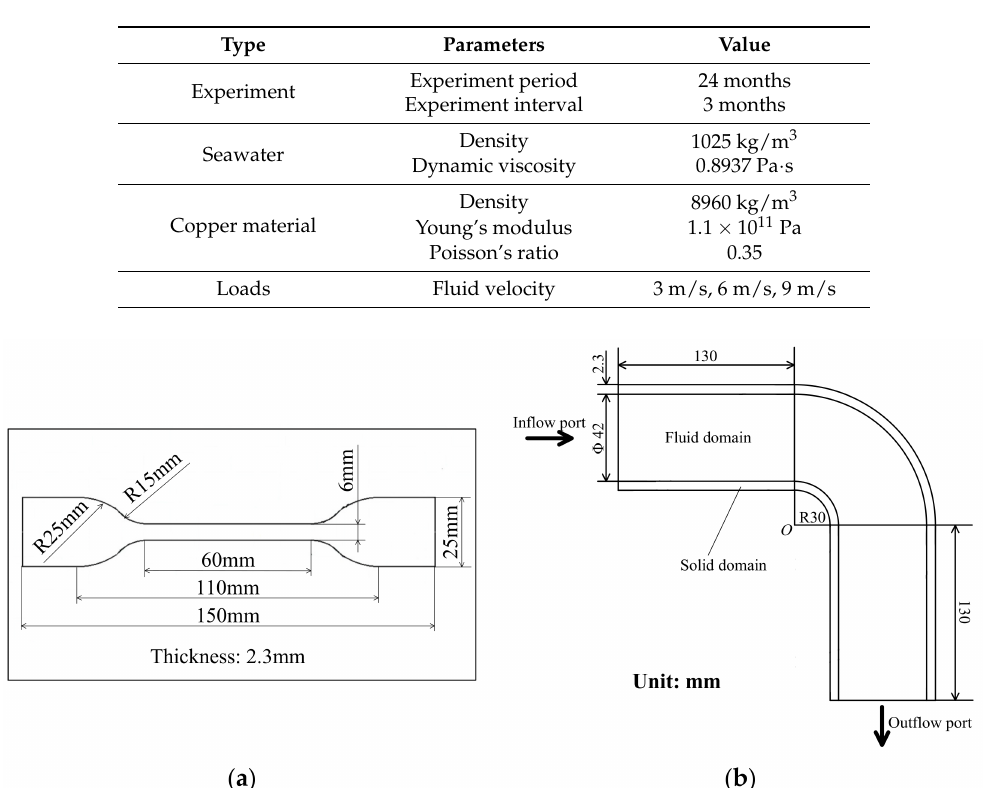
Table 1. Experiment description.